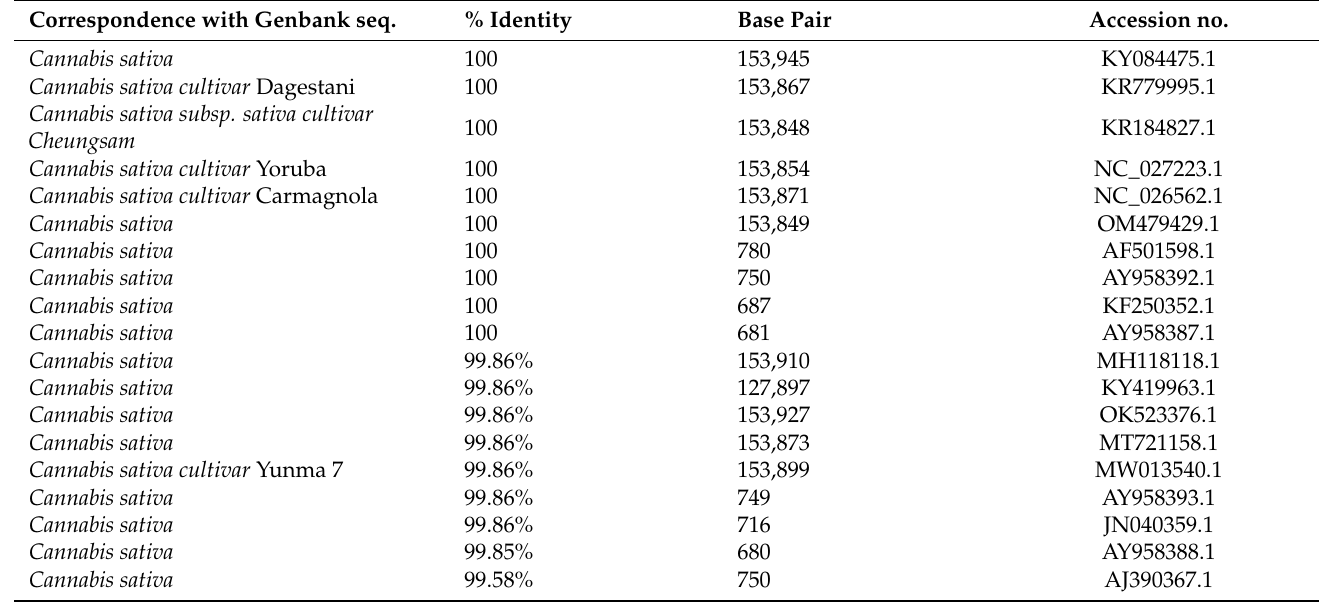
Table 2. Comparison between the sample of C. sativa cv. strawberry and the sequences present on GenBank.